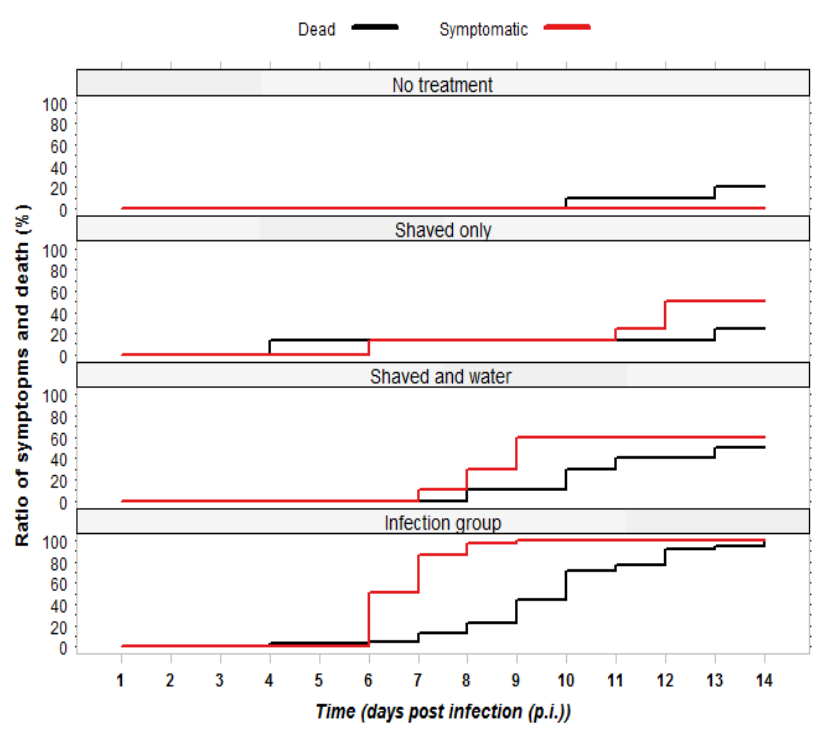
Figure 1. Development of Chronic Bee Paralysis Virus (CBPV) symptoms and cumulative mortality in queens of four experimental groups. The development of symptoms was faster in the infection group, which had a mortality rate of 100%.